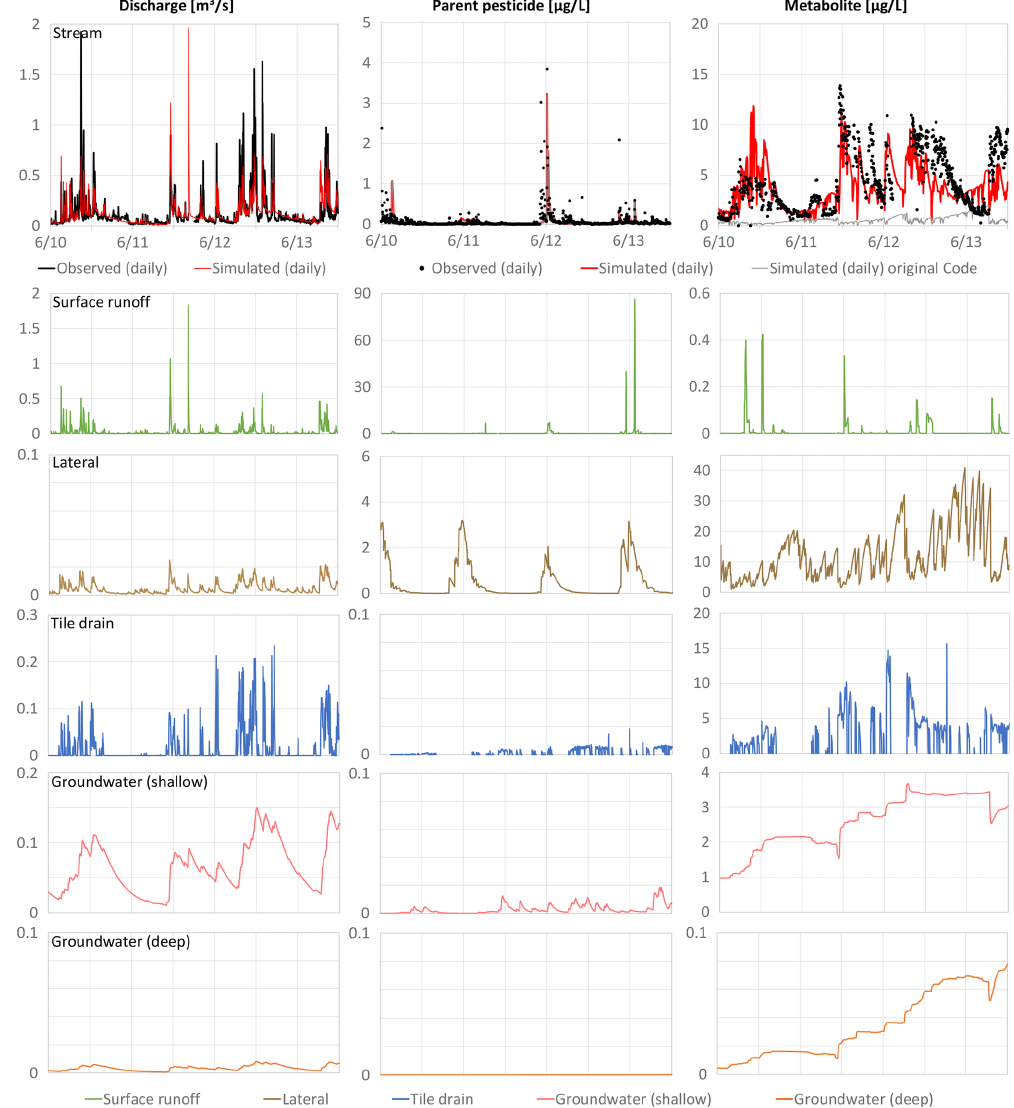
Figure 3. Catchment 2 (C2) time series (June 2010–December 2013) for observed and simulated discharge, parent pesticide, metabolite in streamflow and simulated time series for all flow